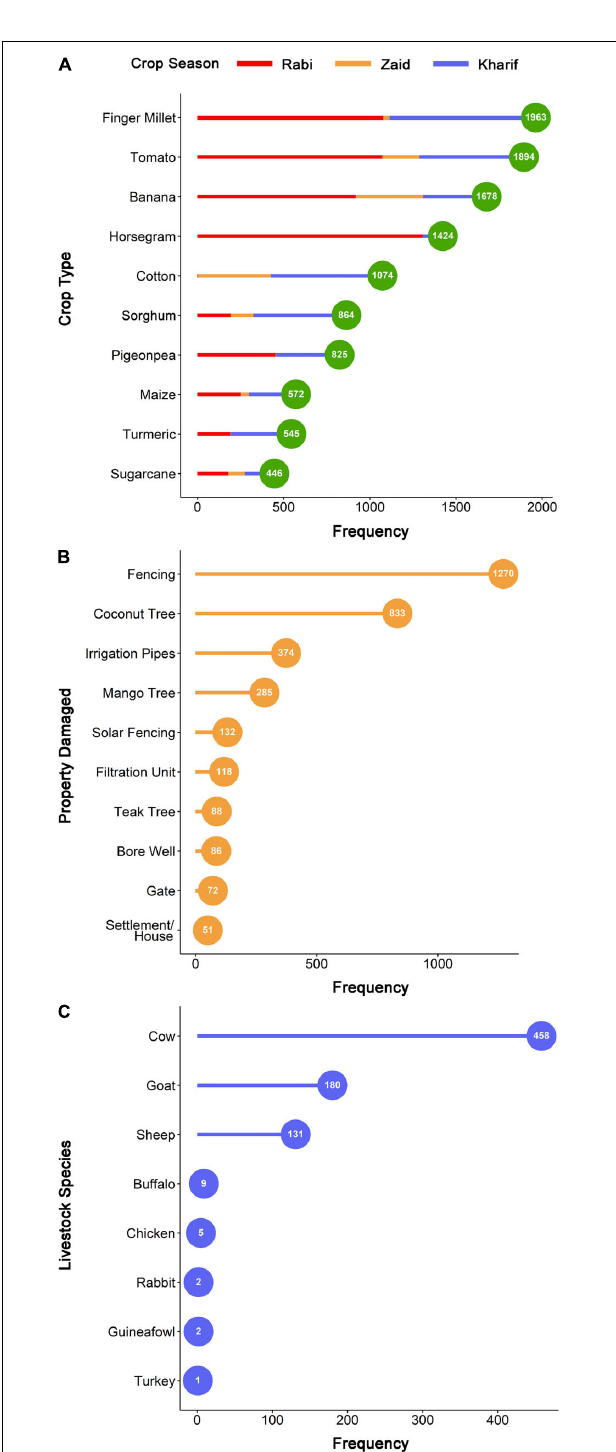
FIGURE 3 | (A) Top 10 crops (by frequency of reporting) damaged in human-wildlife conflict incidents. The cropping seasons of Rabi (Nov–Mar), Zaid (Apr–Jun), and Kharif (Jul–Oct) in which the incidents were reported have been indicated as percentages of the total number of incidents. (B) Top 10 property types damaged in reported human-wildlife conflict incidents. (C) The number of livestock killed by predators recorded by the Wild Seve program. Cows include adult cows, bullocks, and